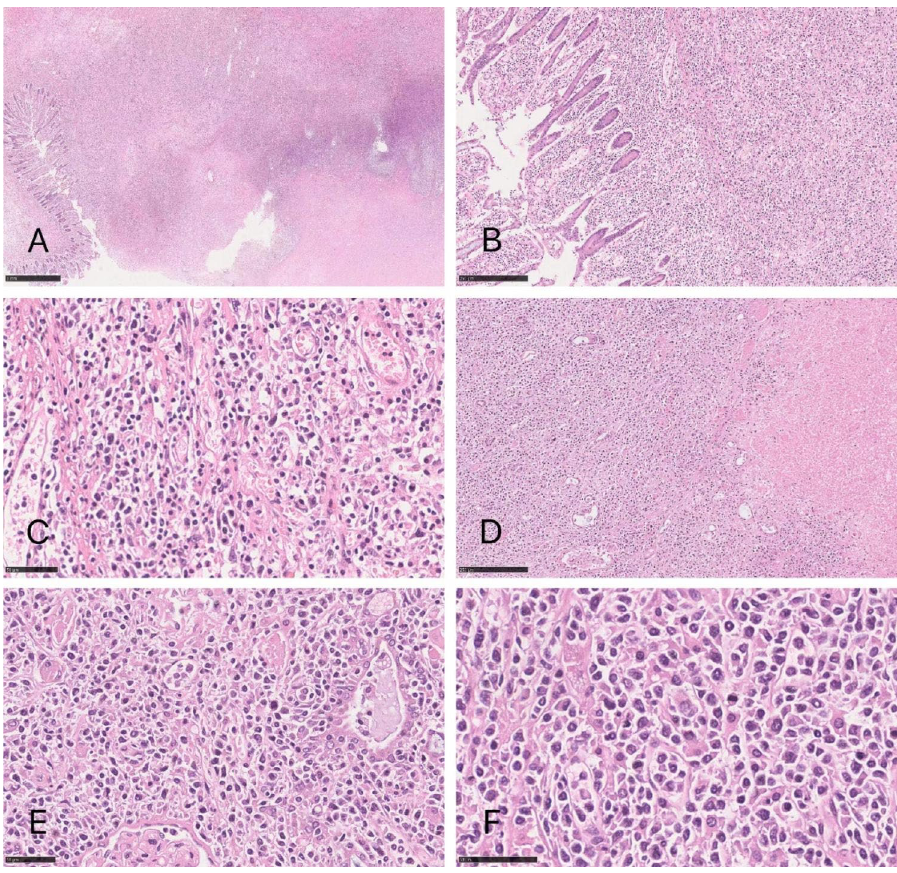
Fig. 2 The tumor cells are diffusely distributed, infiltrating the entire intestinal wall (A, ×20; B, ×100) and renal parenchyma with obvious coagulation necrosis in some areas (D, ×100) . The tumor cells are mainly of small to medium size, with blood vessel invasion observed (C, ×400; E, ×400; F,